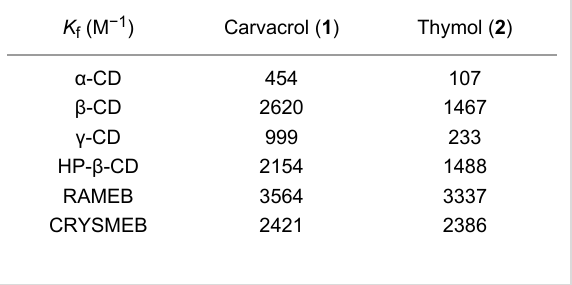
Table 1: Formation constants K f (M − 1 ) of CD/carvacrol ( 1 ) and CD/ thymol ( 2 ) inclusion complexes determined by the competitive UV–visible method at 25